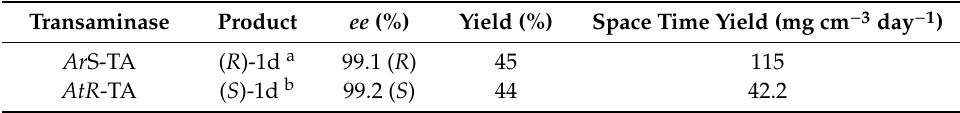
Table 4. Preparative scale production of either ( S )- 1d or ( R )- 1d by kinetic resolution of rac - 1d in continuous-flow mode.